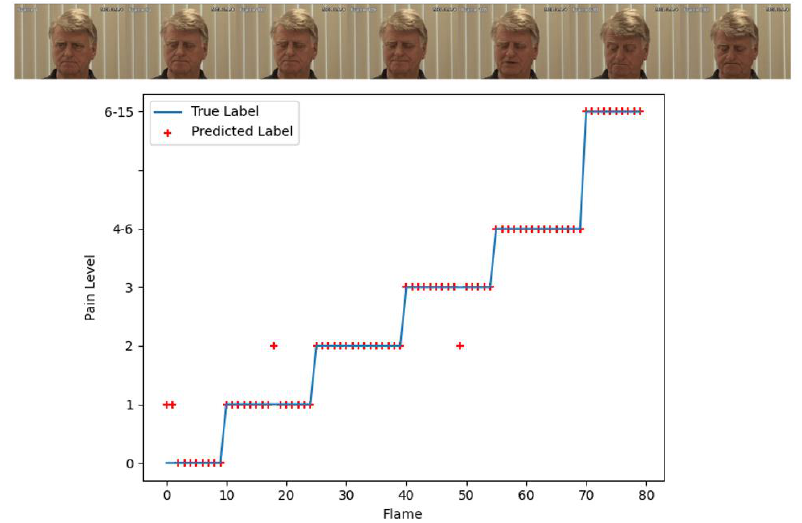
Figure 10. The comparison of the prediction and ground truth for an 80-frame video with pain ex- pression.